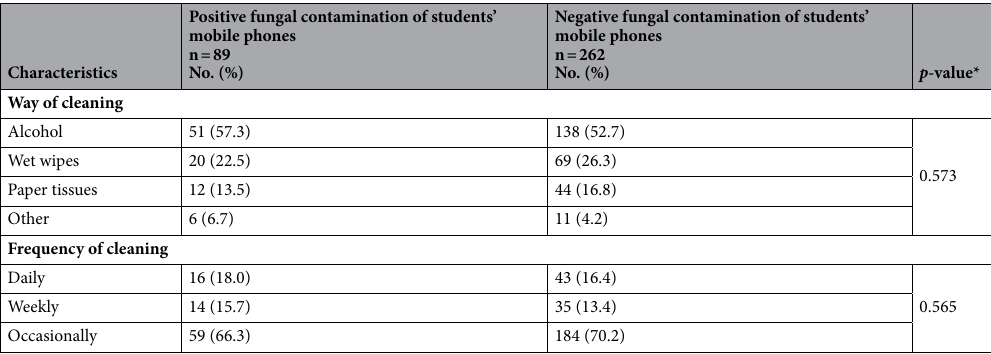
Table 3. Distribution of characteristics regarding mobile phone cleaning habits in 351 students who clean their phones by the presence of fungal contamination of students’ mobile phones. *According to the chi-square or Fisher’s test.